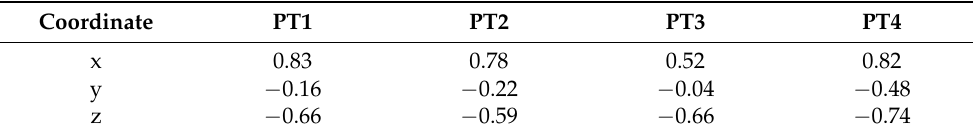
Table 5. Linear correlation index computed between the filtered GNSS displacement time series and the air